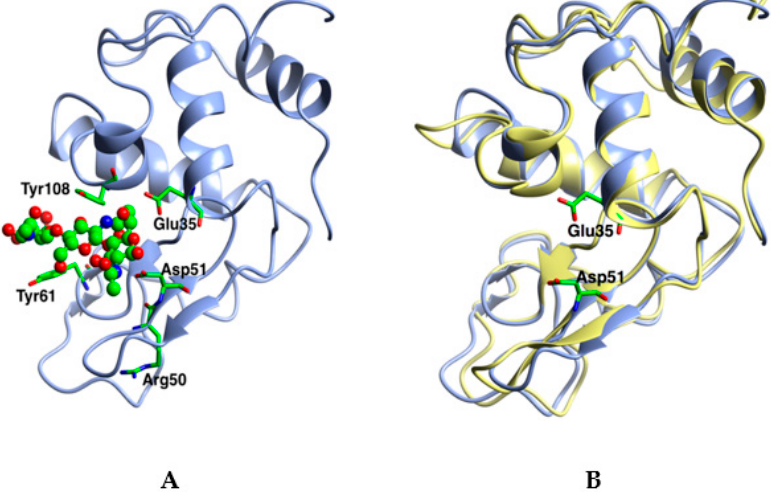
Figure 2. The 3D structure of O. hoazin lysozyme ( Oh Lys). ( A ) Oh Lys shown as ribbons with the chitotriose from the complex as ball and stick binding in sites -1 to -3. The position of the catalytic Glu35 and Asp51 (cylinders) are taken from the apo structure. Three key residues which were subsequently mutated to resemble those in Hen Egg White Lysozyme (HEWL) are also shown as cylinders: Arg50, Tyr61 and Tyr108. ( B ) Superposition of the Oh Lys (blue) on HEWL (yellow). The GH22 fold is highly conserved over a range of organisms, as can be seen in Table 2, where the r.m.s. difference in C α position over between 112 and 125 residues is between 0.79 and 1.4Å, from